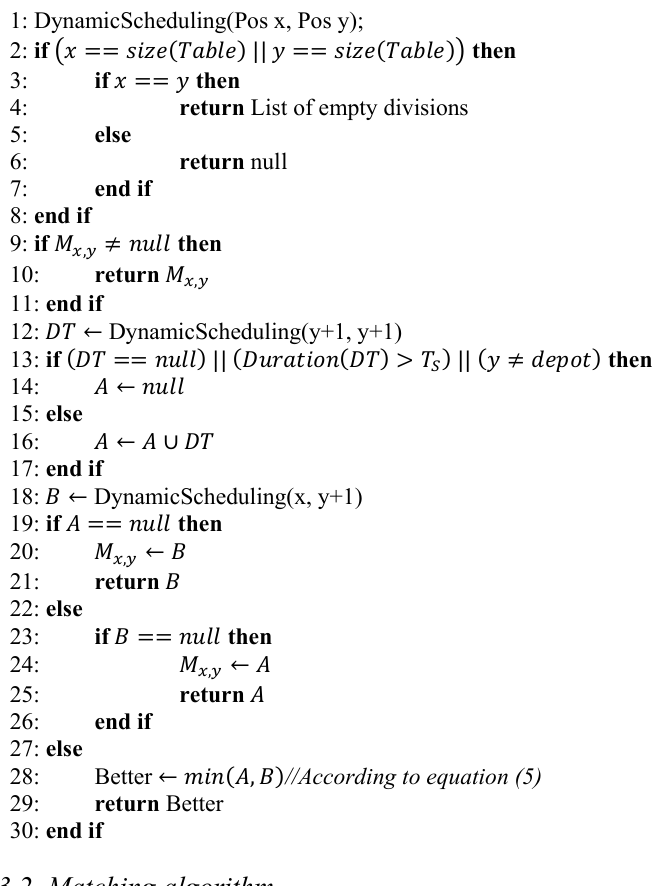
Algorithm 2 Dynamic Scheduling